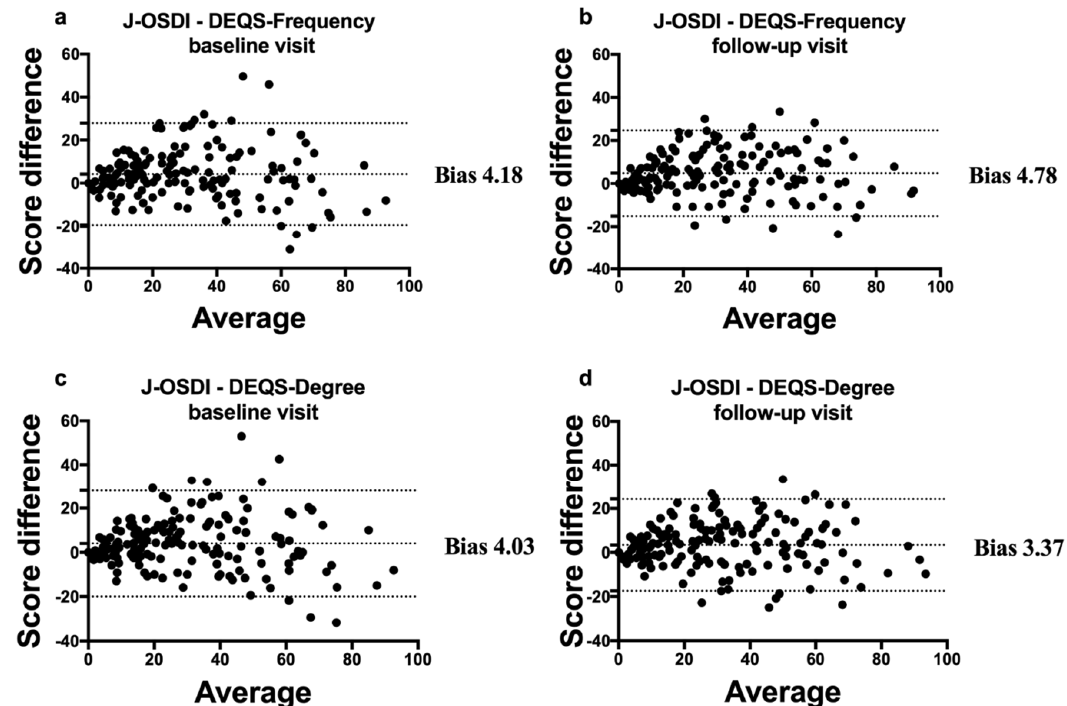
Figure 4. Bland–Altman plot for the J-OSDI total score and DEQS (Frequency and Degree). The x-axis indicates the average of the two questionnaire scores, and the y-axis indicates the difference between the two questionnaire scores (J-OSDI and DEQS). The central line indicates the mean difference (bias) between the scores from the two questionnaires, whereas the superior and inferior lines depict the intervals, which include the 95% limits of agreement. Differences between the J-OSDI and DEQS (Frequency) at the baseline visit ( a ) and follow-up visit ( b ). Differences between the J-OSDI and DEQS (Degree) at the baseline visit ( c ) and follow-up visit ( d ).